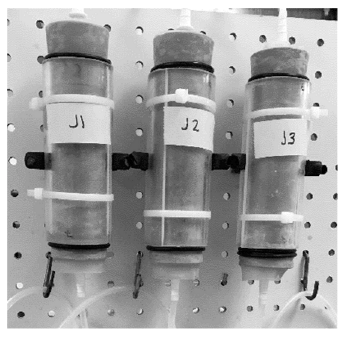
Figure 3. Columns attached to frame.